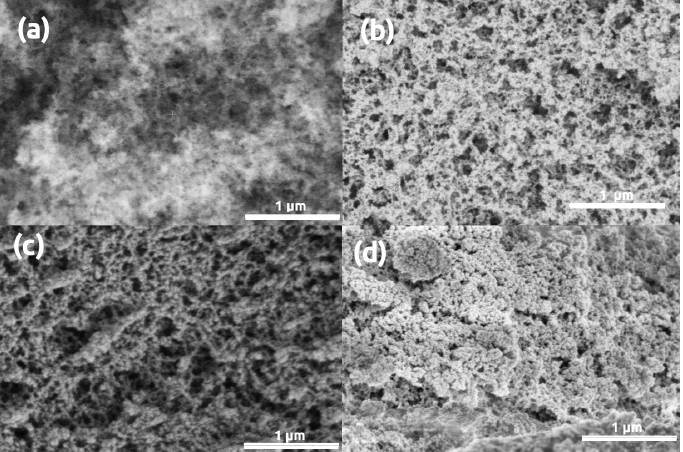
Figure 3. LVSEM images of silica-gelatin aerogel samples. ( a ) Pristine, uncoated. ( b – d ) Sputter coated with 5 nm, 16 nm, 32 nm thick Au layers, respectively.